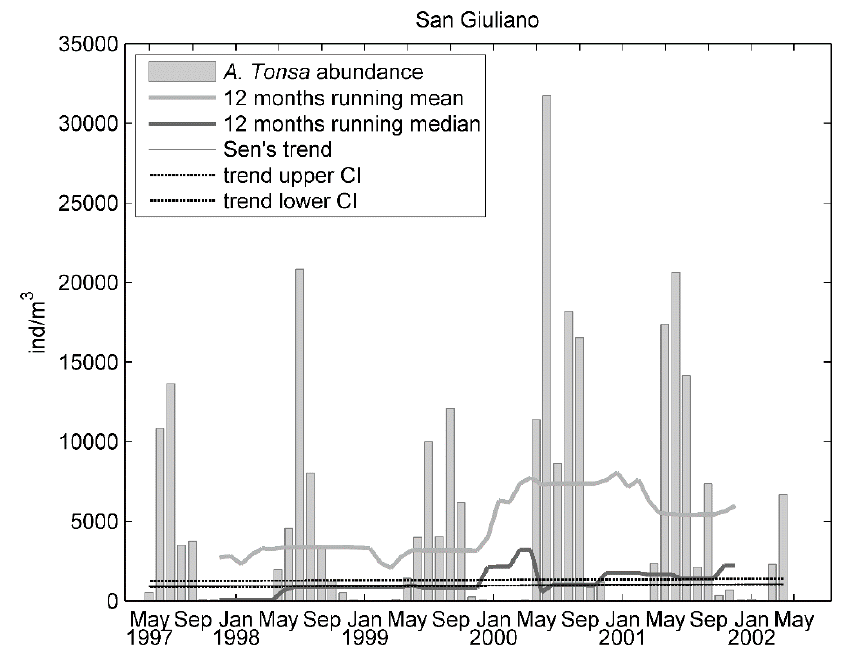
Figure 4. Time series of monthly A. tonsa abundance (bars) along with a 12-month running mean and median and Sen’s trend line at the San Giuliano station during 1997–2002.